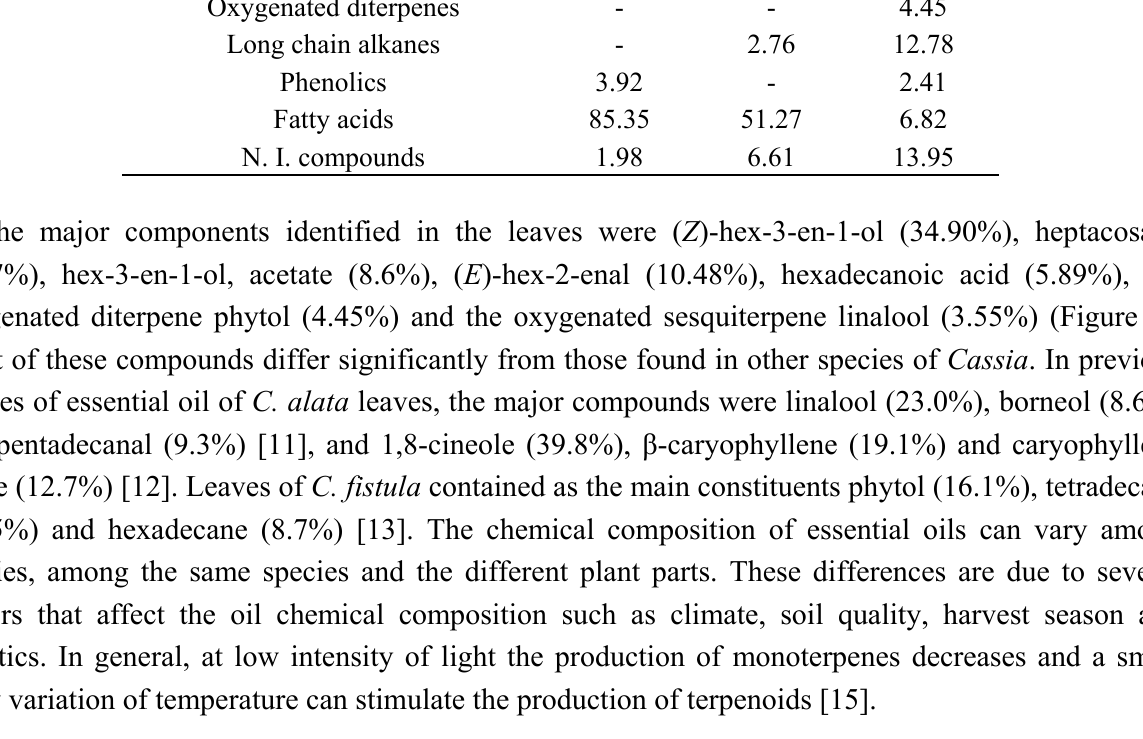
Figure 1. Major components in the leaf oil ( A ) and bark ( B ) of C.